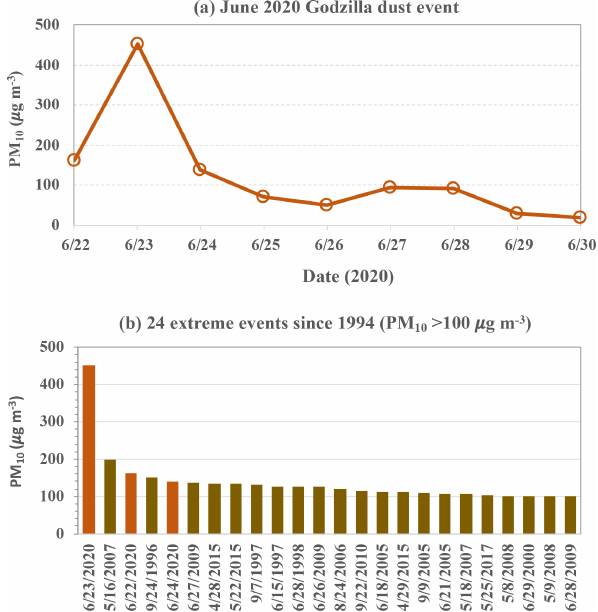
Figure 6. (a) PM 10 concentration measured at Catano, Puerto Rico, during the June 2020 dust event, (b) 24 extreme dust events (PM 10 > 100µgm − 3 ) at this site since